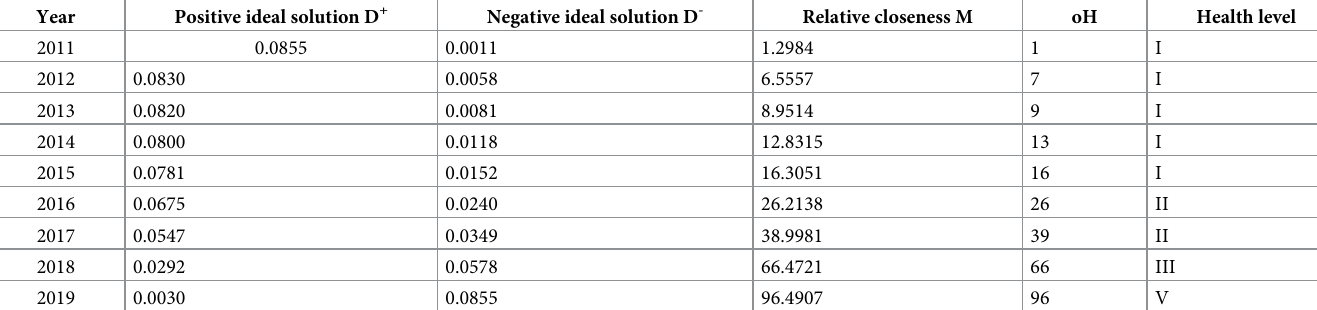
Table 4. 2011–2019 health of pharmaceutical innovative ecological rainforest in Zhejiang Province.